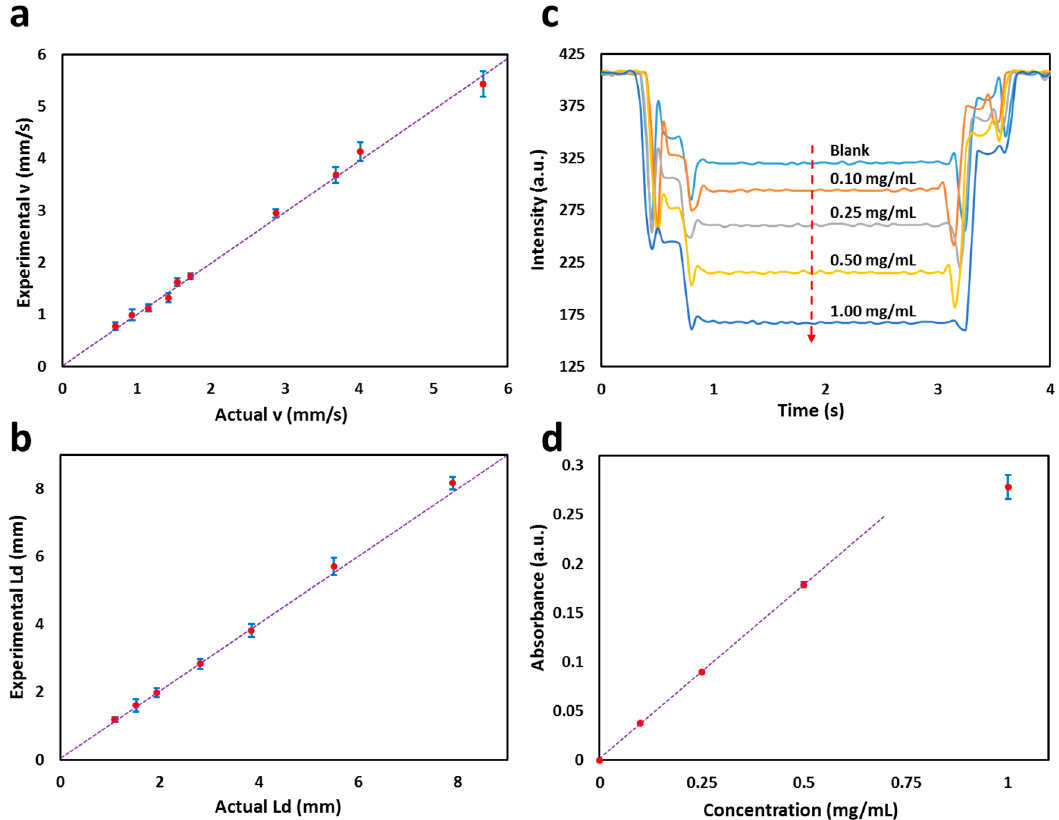
Figure 4. Characterization of the flow cell: ( a ) Experimental velocity vs. actual velocity; ( b ) Experimental droplet length vs. actual droplet length. The dotted line shows the 1:1 equivalence; ( c ) Transmitted light intensity response of blank (pure water) and red food dye concentrations (0.10, 0.25, 0.50, and 1.00 mg/mL) as a voltage output from the photodiode. The arrow shows the increase in concentration of the red food dye; ( d ) Plot of absorbance against droplets containing red food dye concentration measured in the flow cell with dual light paths. Droplet absorbance against dye concentration. A line of best fit ( R 2 = 0.999) shows the linear response for absorbance values < 0.2.